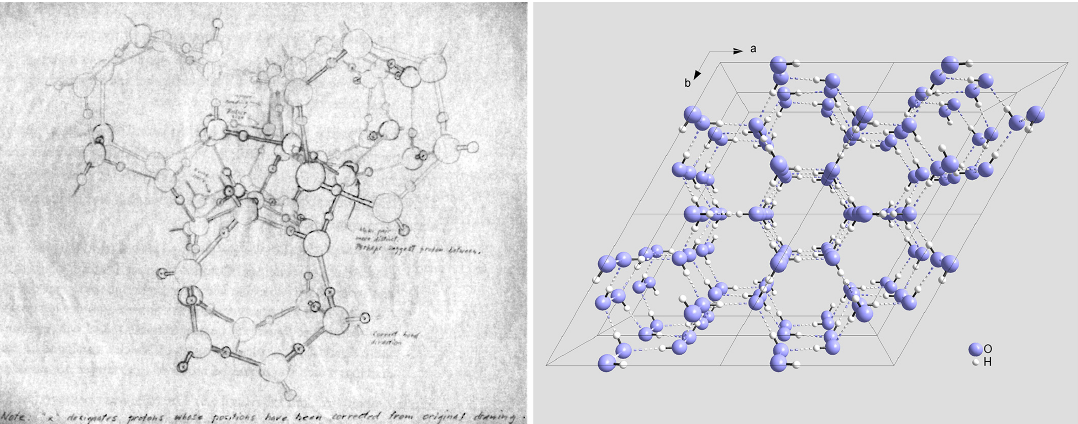
Figure 5. Ice crystals structure, pencil drawing on paper and computer processing (Software Diamond 3.1) [14] (p. 226),